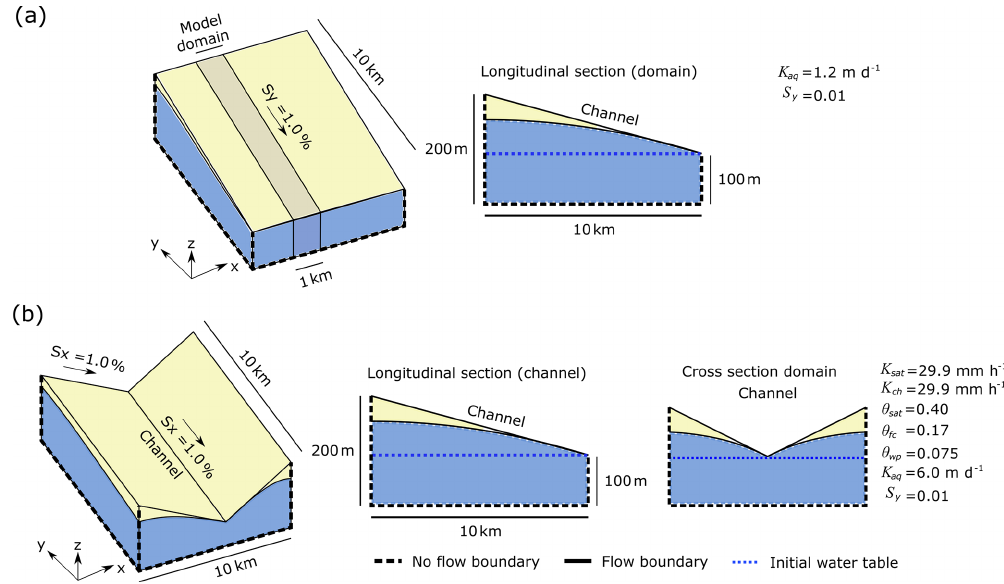
Figure 4. Model domain for the synthetic experiments: (a) 1-D model, and (b) tilted-V catchment and flow boundary conditions specified for model simulations.